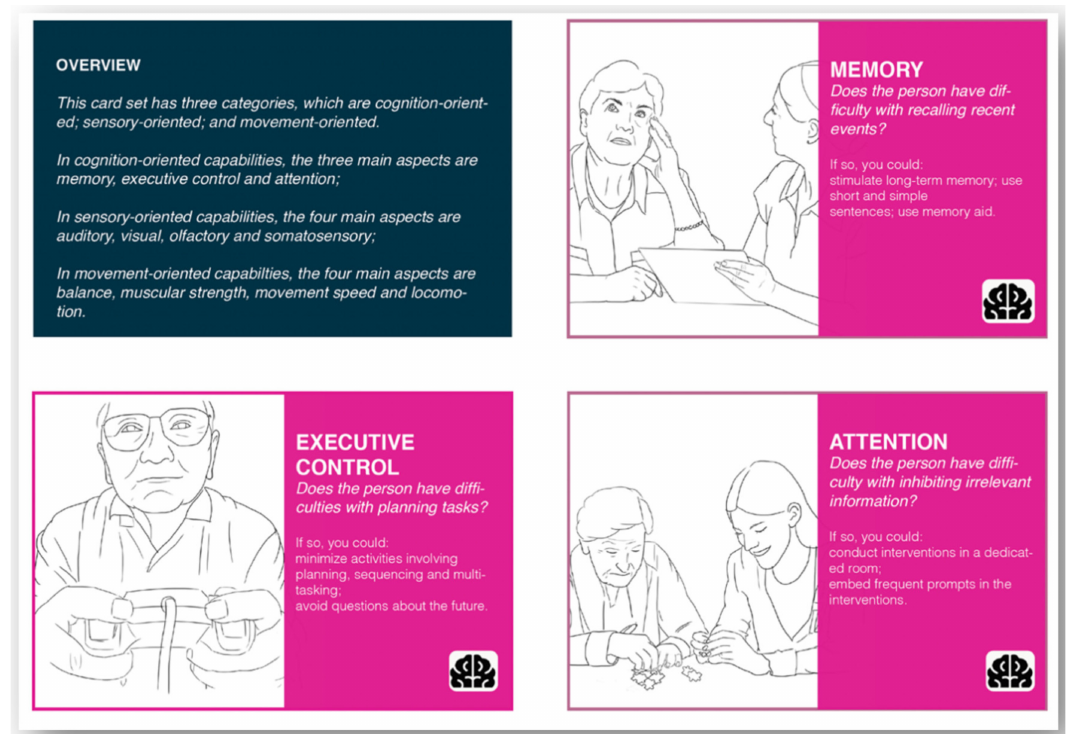
Figure 2. The overview instruction card and the cards for cognition-oriented capabilities.